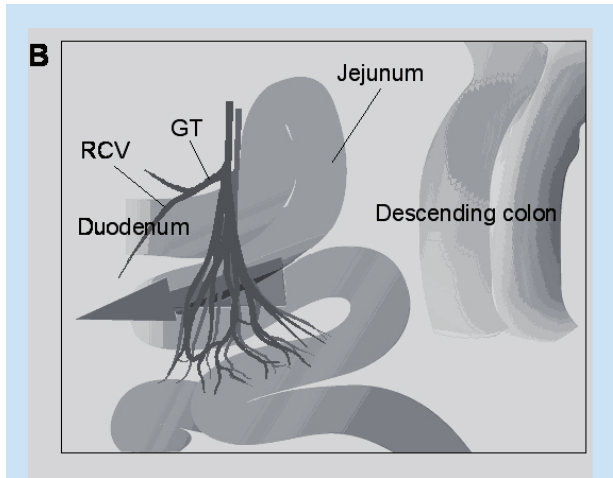
Fig. 4b. Schematic illustration demonstrating a right paraduodenal hernia into the fossa of Waldeyer behind the branches of the superior mesenteric artery and